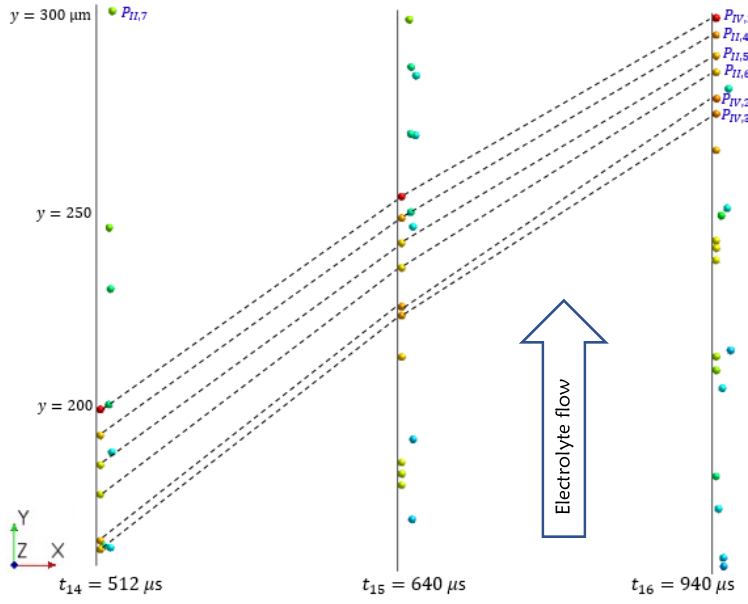
Figure 19 The Star CCM+ simulation results from 𝑡 14 = 512 µs to 𝑡 16 = 940 µs